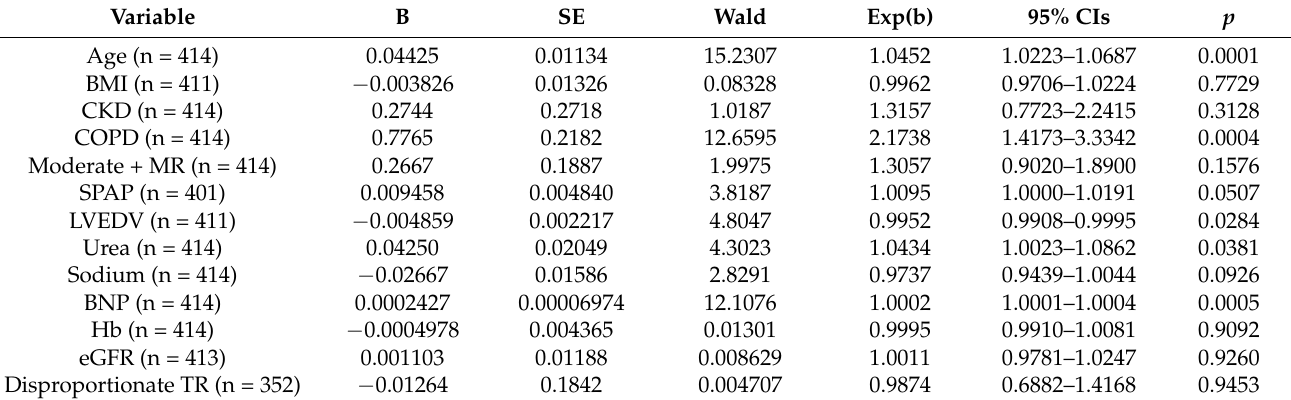
Table 6. Multivariate analysis of the full